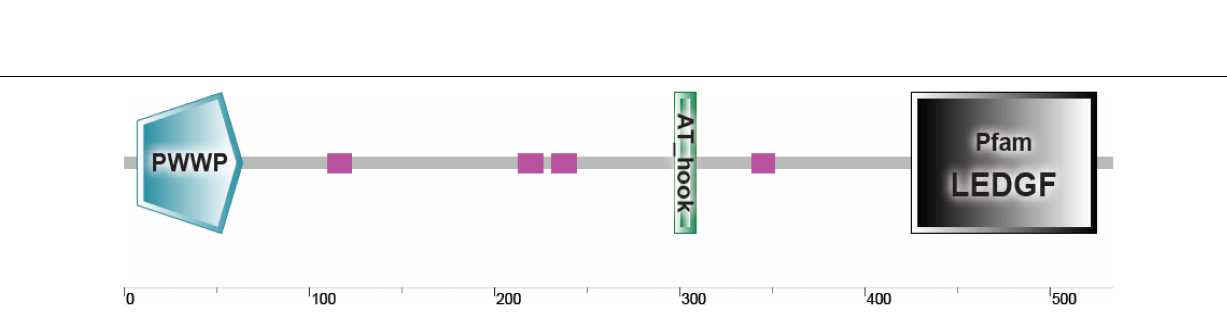
Frontiers in Marine Science |